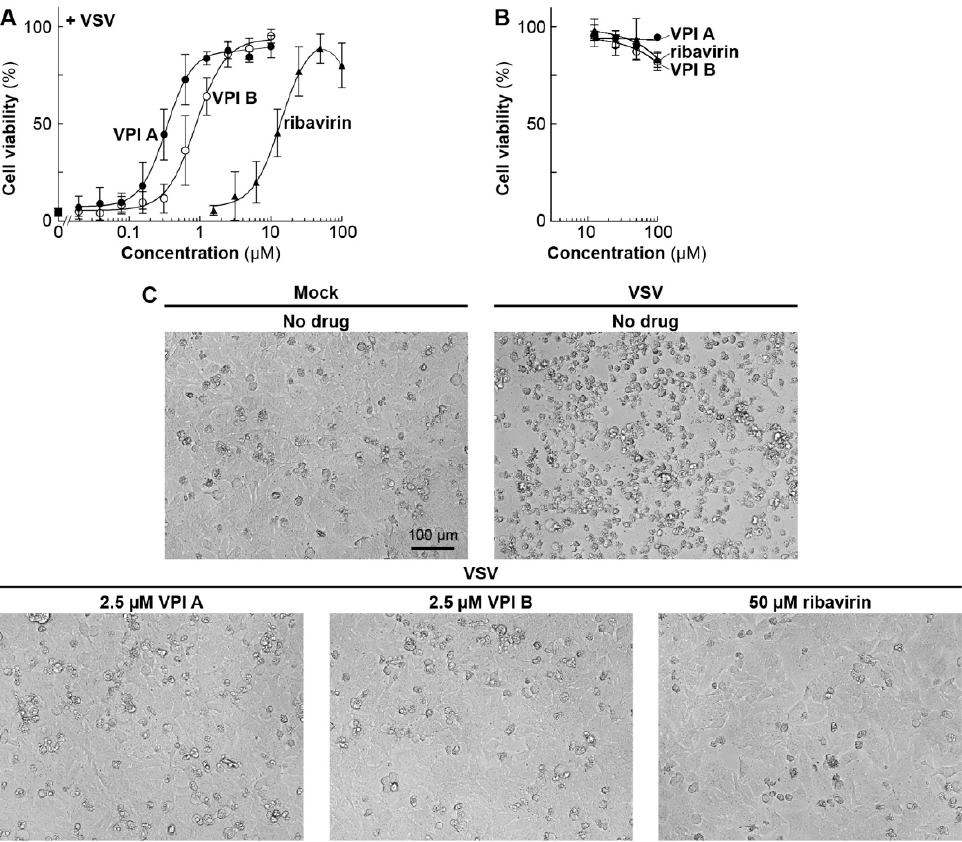
Figure 4. Anti-VSV activities of VPIs A and B in HeLa cells. HeLa cells in 96-well plates were mock-infected or infected with VSV at an MOI of 0.1 in the presence of different concentrations of VPI A (closed circles), VPI B (open circles), or ribavirin (closed triangles), and cultured for 65 h. The cell viability of infected ( A ) or mock-infected ( B ) cells was determined as described in Figure 2. The mock-infected or infected cells in the presence or absence of the indicated compounds were observed under a microscope ( C ).